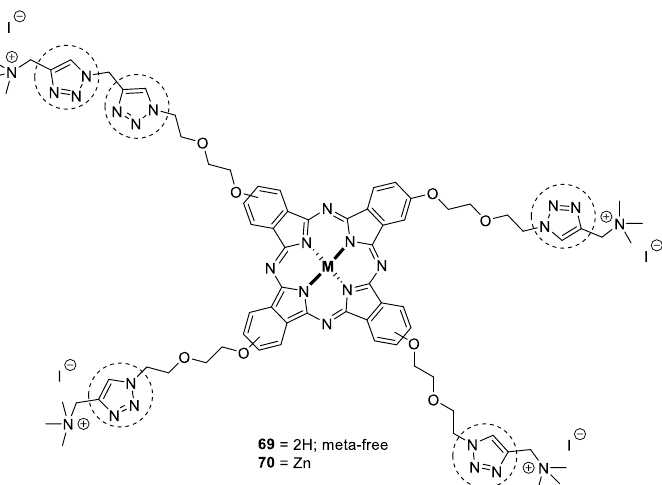
Figure 23. Chemical structure of metalophthalocyanines – 1,2,3-triazole conjugates. 1,2,3-triazole derivatives substituted with zinc, magnesium, and lead phthalocyanines have also been synthesized. The synthesized derivatives showed outstanding solubility in most of the common organic solvents, including 1,4-dioxane, chloroform, acetonitrile, DMF, DMSO, tetrahydrofuran, and ethyl acetate. Peripherally tetra-substituted zinc phthalocyanine ( 71) generates high singlet oxygen in DMSO as compared with unsubstituted zinc phthalocyanine; thus, it may be explored further for photosensitizers in photodynamic therapy. The effective generation of single oxygen acts as an effective photosensitizer in photodynamic cancer treatment. The nonperipheral magnesium phthalocyanine ( 72) has shown the highest inhibitory activity against AChE (IC 50 = 37.98 µM) and α -glucosidase (IC 50 = 54.05 µM) using spectrophotometric methods (Figure 24) [113].